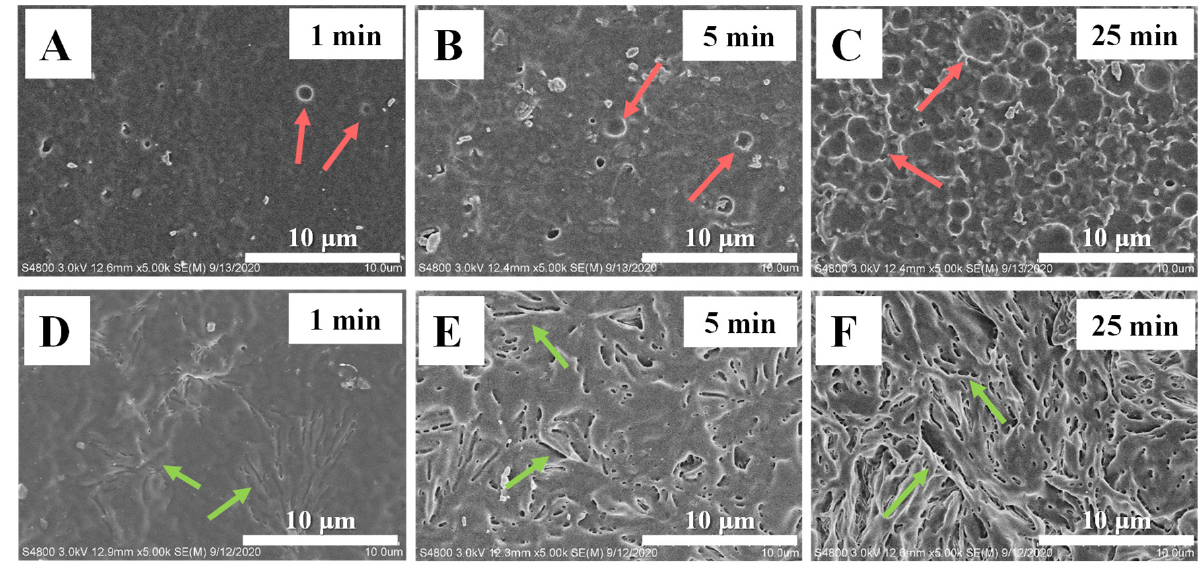
Figure 5. SEM images of modified PLLA membranes upon alkali hydrolysis for the indicated time in PLLA 0 ( A – C ) and PLLA 60 ( D – F ).